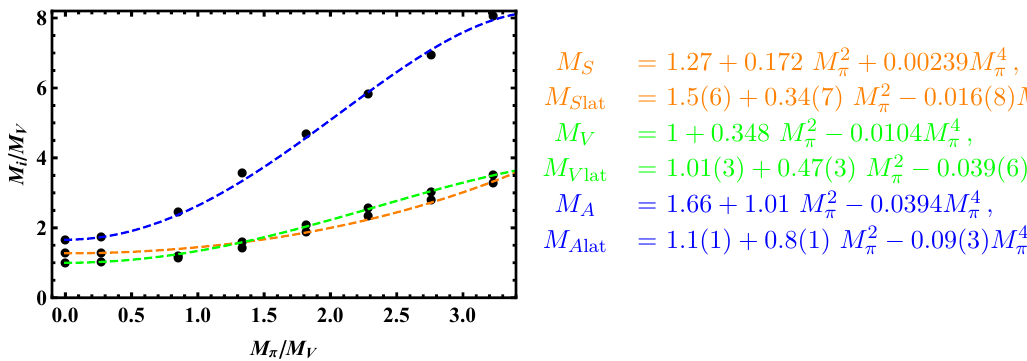
Figure 10. The growth of the spectra in the SU(2) theory as we increase the quark mass in the UV. The masses are rescaled with respect to the vector meson mass at m q | UV = 0 . In our analytic formulae quantities are again normalized to the vector meson mass at m q | UV = 0